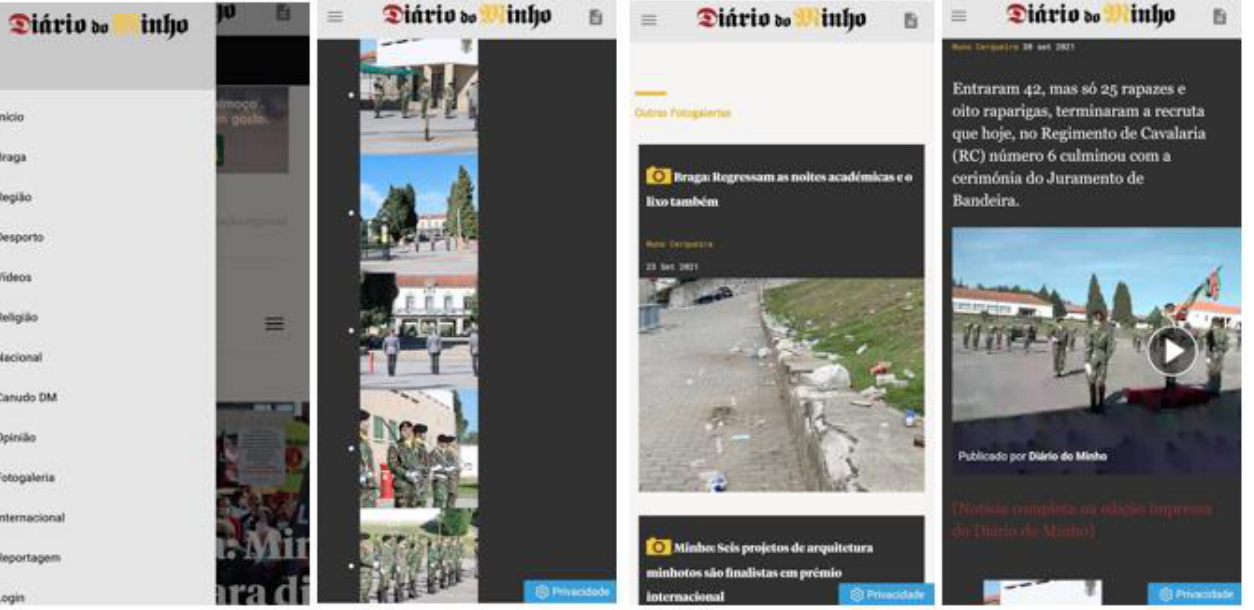
Figure 1. Video or photo galleries of the app Diário do Minho without geo-tagging system.